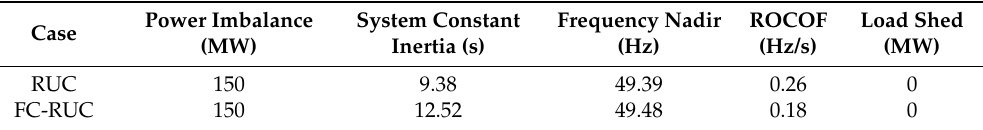
Table 6. Summary of Contingency 2 at Hour